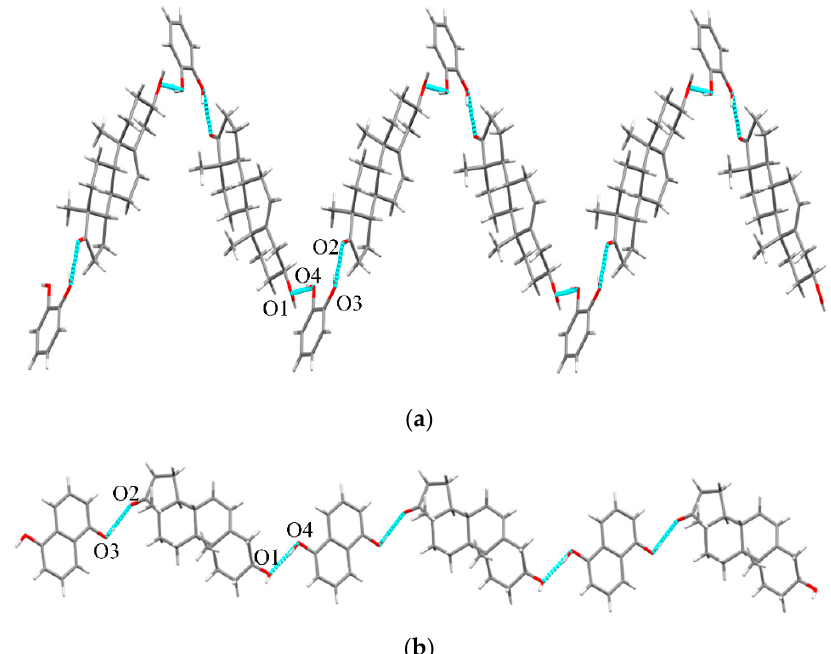
Figure 3. 1D hydrogen-bonding interaction of ( a ) DHEA-CAT and ( b ) DHEA-DHN.